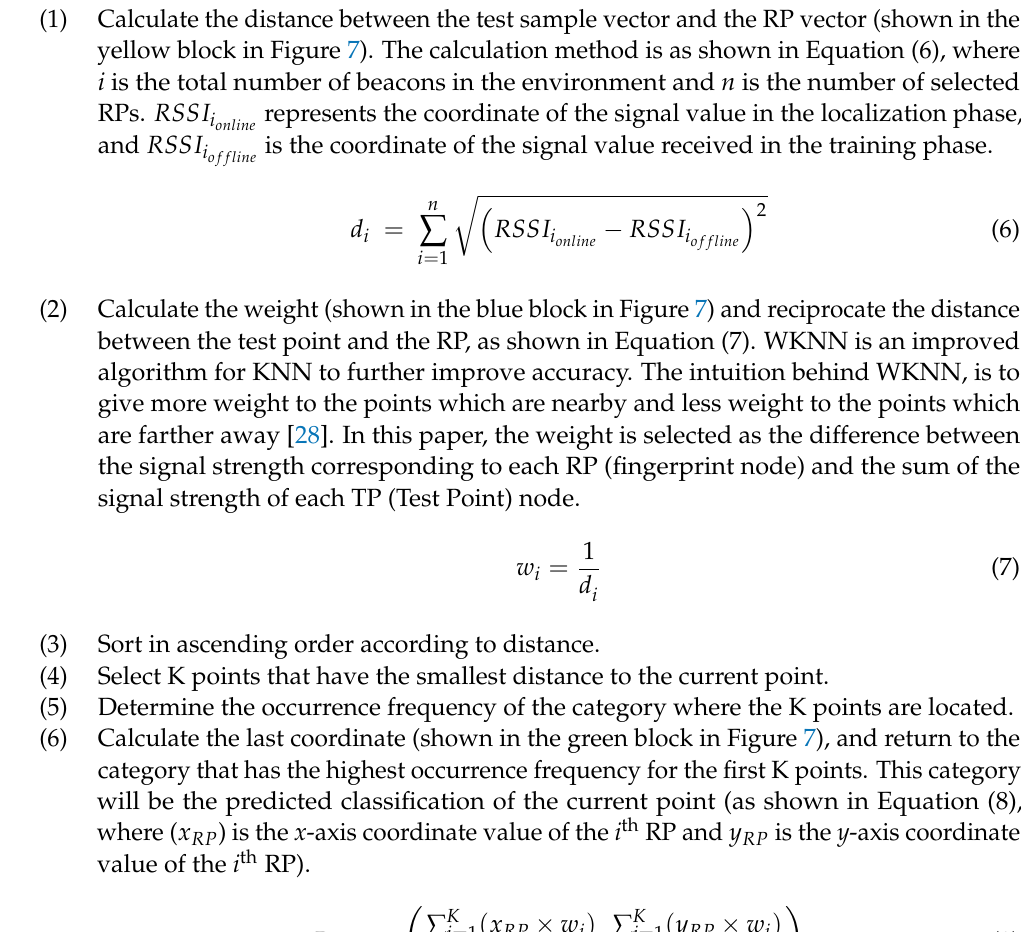
Figure 7. Process of the weighted K-nearest neighbors algorithm. Calculate the distance between the test sample vector and the RP vector (shown in the yellow block in Figure 7). The calculation method is as shown in Equation (6), where i is the total number of beacons in the environment and n is the number of selected RPs. RSSI i represents the coordinate of the signal value in the localization phase, online and RSSI i is the coordinate of the signal value received in the training phase. of fline